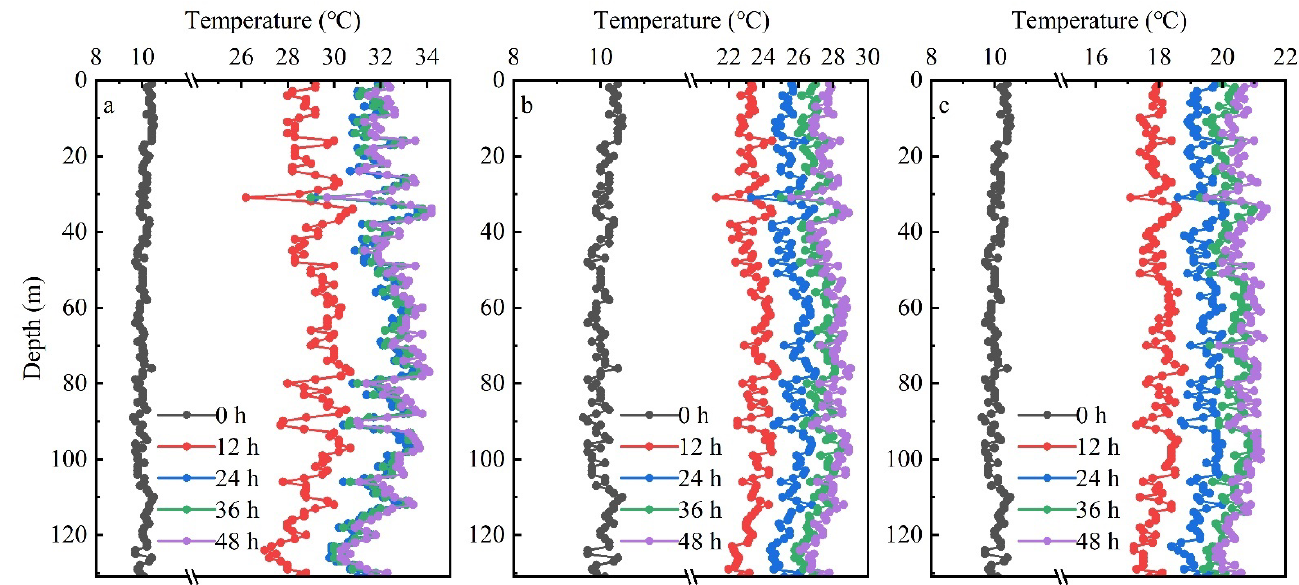
Figure 7. Temperature change at each depth of the formation. ( a ) Condition A. ( b ) Condition B. ( c ) Condition C.